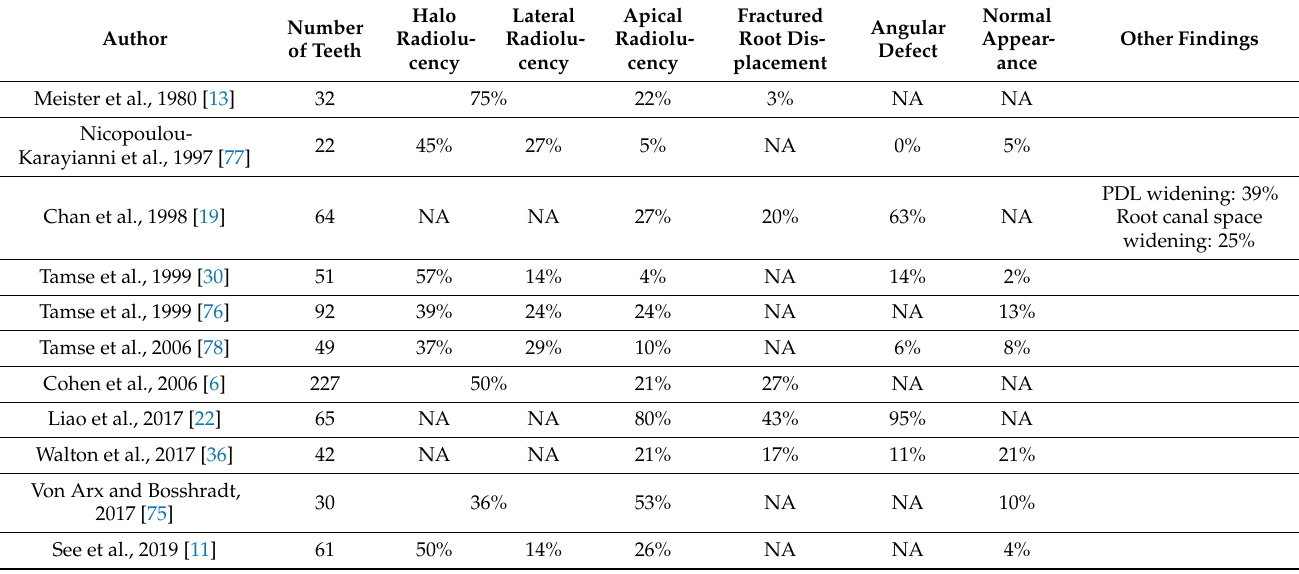
Table 2. Radiographic features of a VRF.